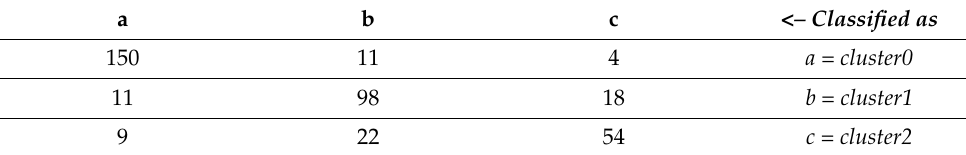
Table 6. Confusion Matrix.